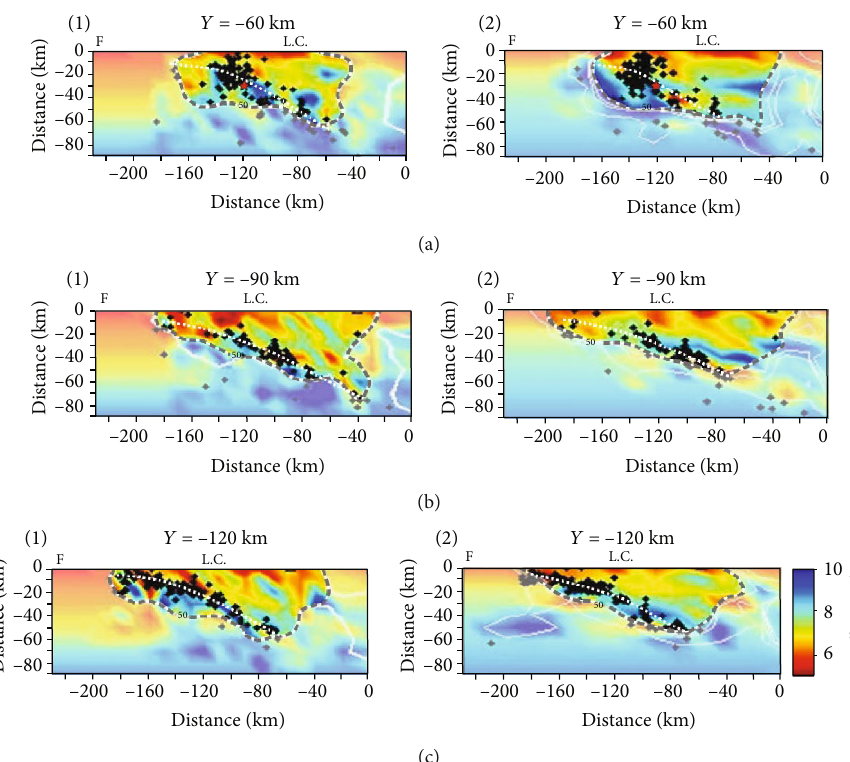
Figure 3: Evolution of the (Vp) velocity model and relocated hypocenters through the inversion TomoDD, obtained for the vertical cross- sections Y = − 60km (a1, a2), Y = − 90km (b1, b2), and Y = − 120 km (c1, c2) perpendicular to the trench axis, located to the north, center, and south of the Paracas Peninsula. Left: Velocity model obtained after the fi rst iteration. Right: Final velocity model obtained after 30 iterations (last). DWS = 50 (derivative weight sum) roughly de fi nes the limit between the high- and low-resolution areas (dashed gray line); the tendency of hypocenter locations is shown by the dashed white lines, and the red star corresponds to the main event